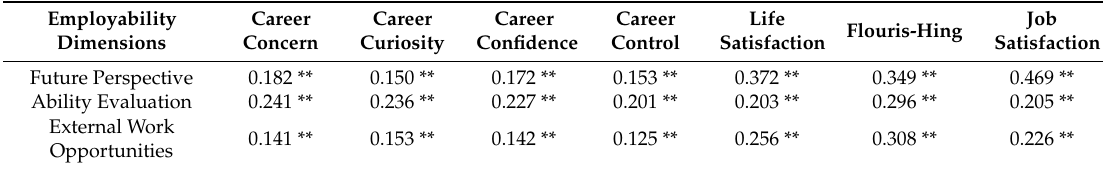
Table 4. Correlations between Self-Perceived Employability Scale, Career Adaptability sub-dimensions and Well-Being